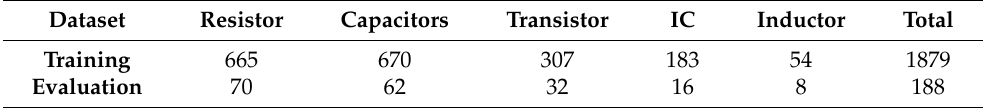
Table 2. Distribution of